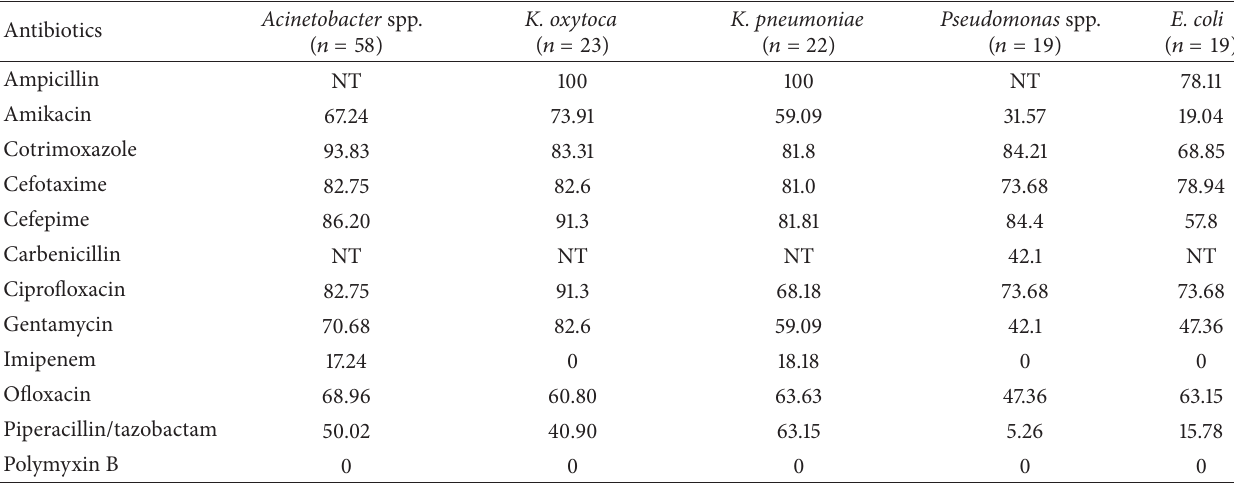
Table 3: Antibiotics profile of major Gram negative pathogens.